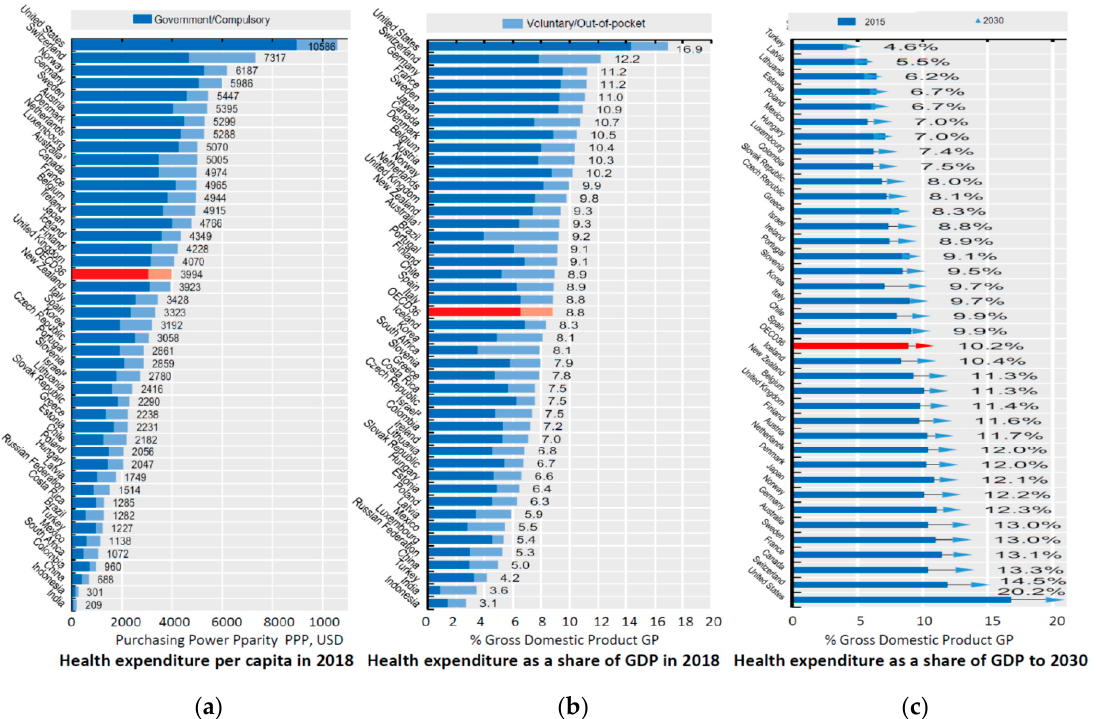
Figure 26. Comparison of the health expenditure in 2018 in the OECD countries ( a ) per capita, ( b ) as a share of GDP, ( c ) as a share of the GDP projected in 2030.